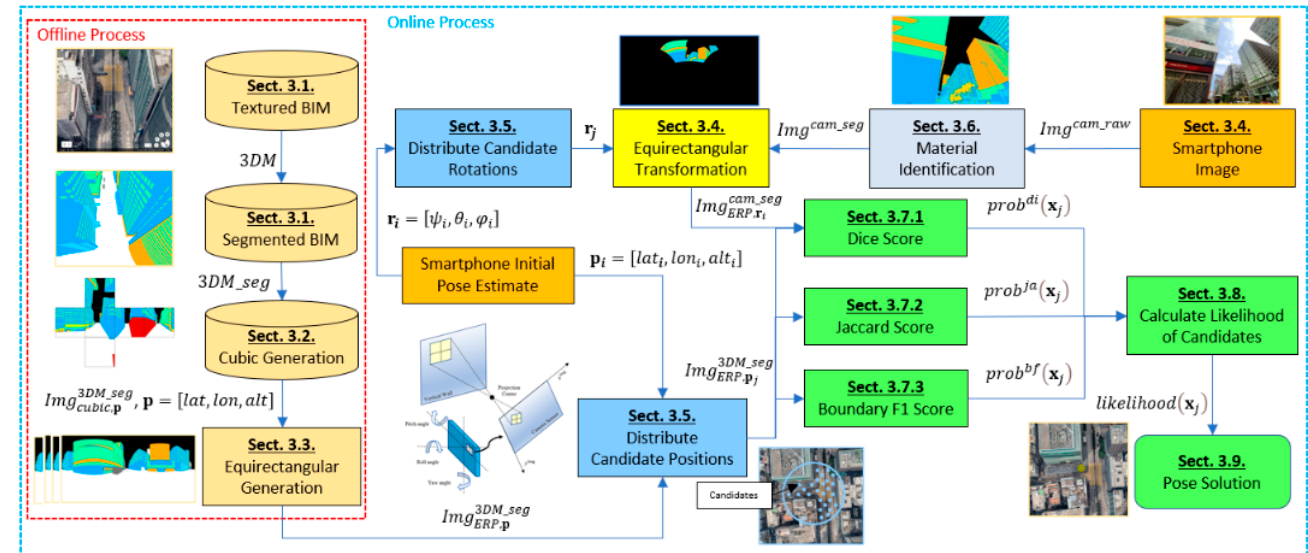
Figure 1. Flowchart of the proposed semantic VPS based on segmented smartphone images and segmented generated images.